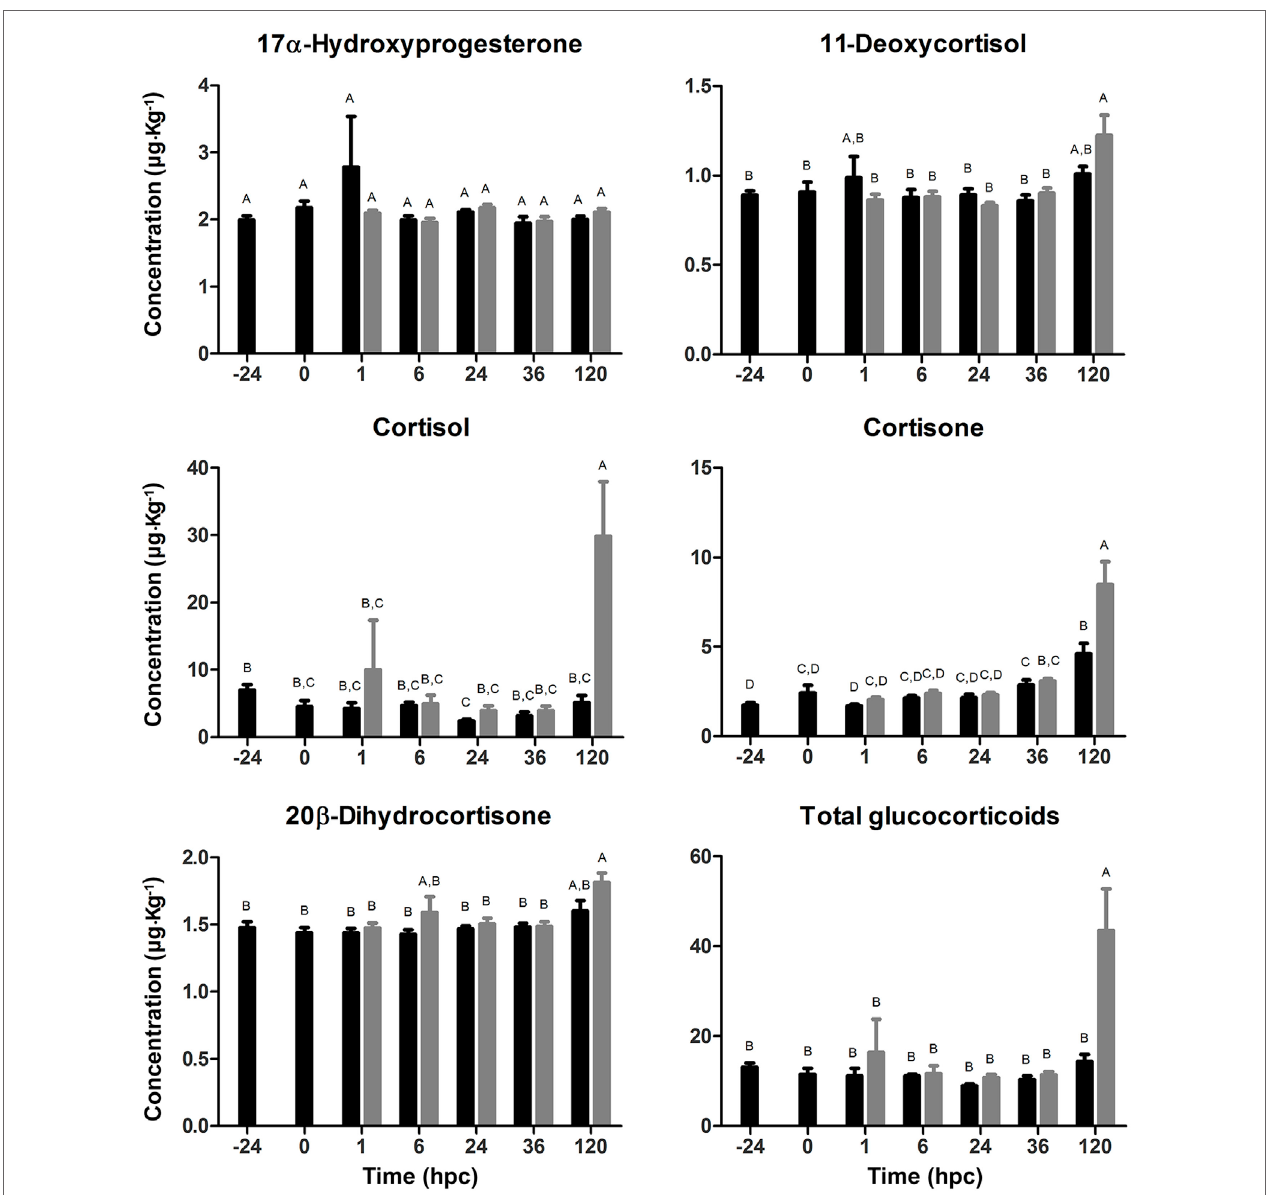
FigUre 3 | Glucocorticoid profile (mean ± SE) in full-sibling sea bass larvae challenged with Vibrio anguillarum . The amount ( μ g kg − 1 whole body) of 17 α - hydroxyprogesterone, 11-deoxycortisol, cortisol, cortisone, 20 β -dihydrocortisone, and total glucocorticoids was quantified from whole-single larva ( n = 10 per time point) in each time [hours post-challenge (hpc)] for non-challenged (black bar) and challenged group (gray bar). Significant differences (linear regression model with Tukey correction posttest) are shown by different capital letters (A, B; p <